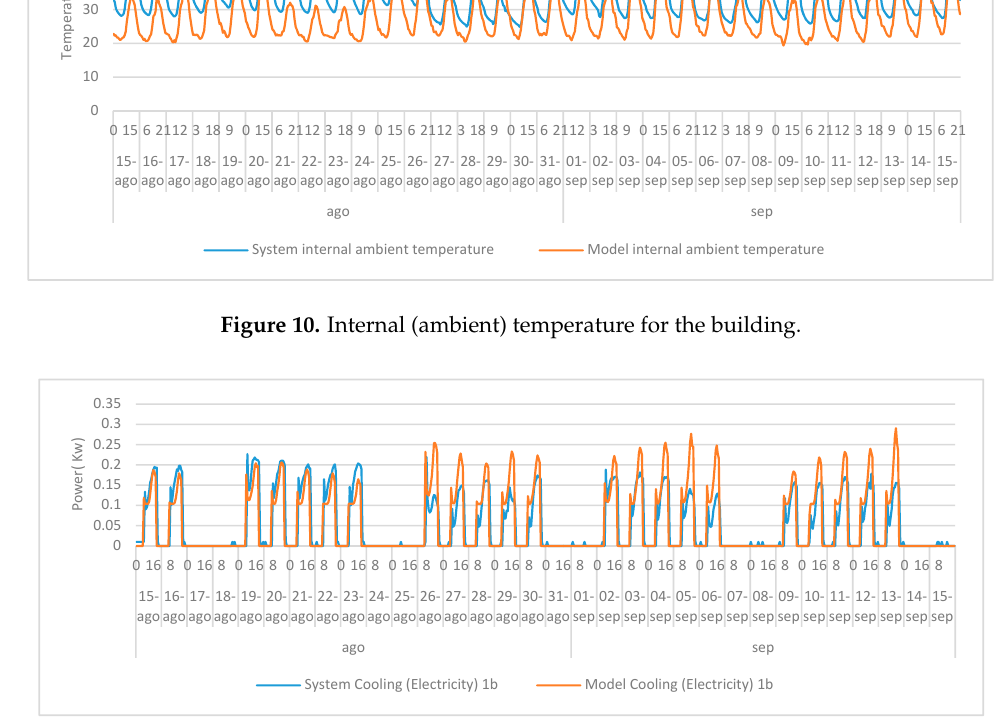
Figure 10. Internal (ambient) temperature for the building.